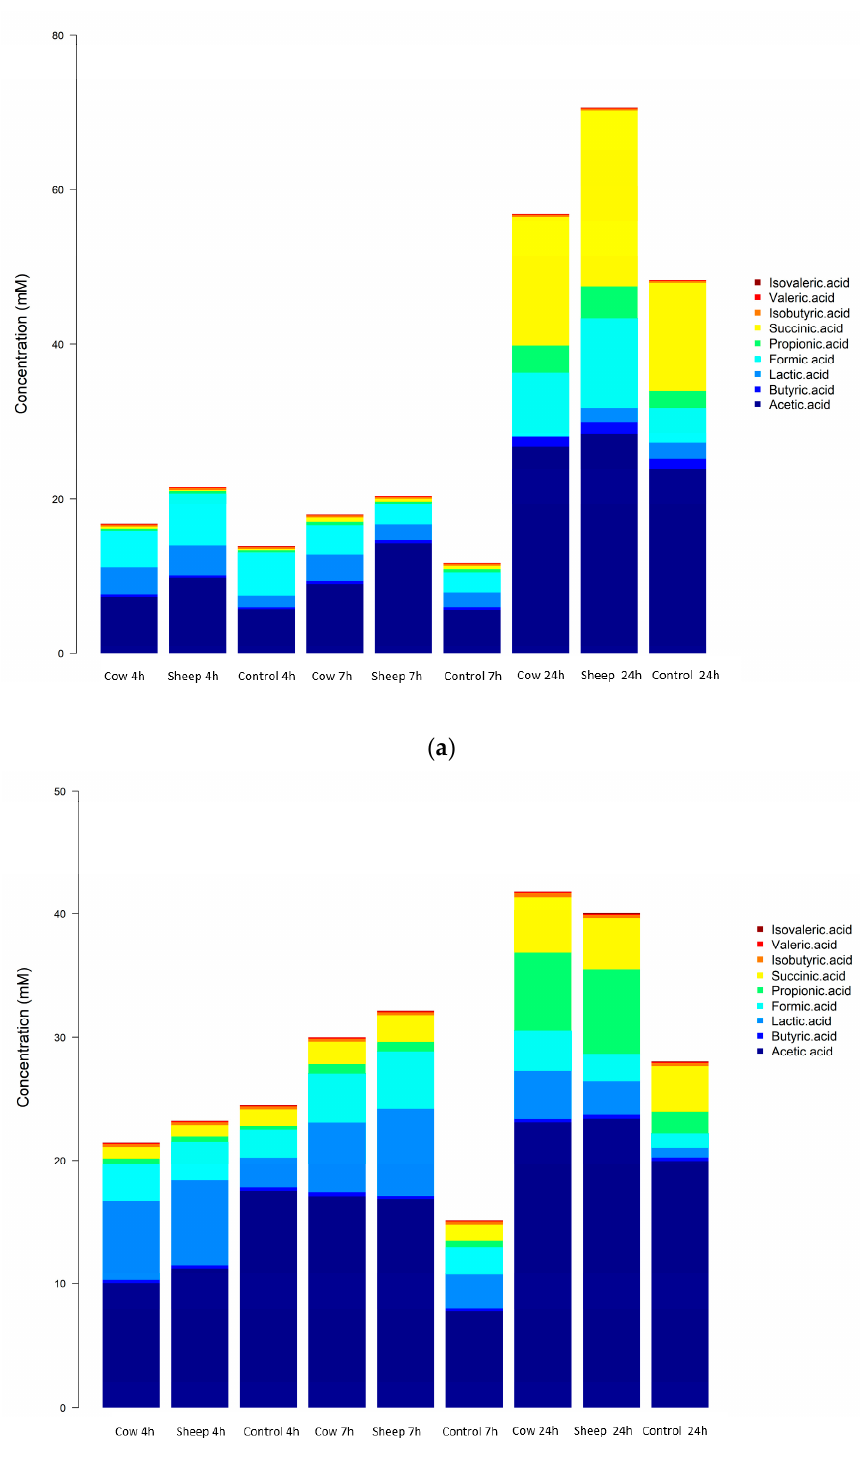
Figure 6. ( a ): One-month-old infant fecal fermentation—short chain fatty acids detected by gas chromatography . ( b ): Five-month-old infant fecal fermentation—short-chain fatty acids detected by gas chromatography .